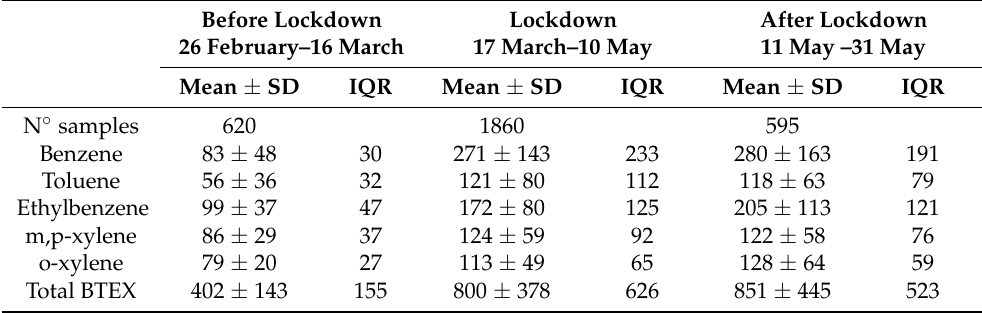
Table 1. Average mixing ratios (pptv) of BTEX for each period (before, during, and after lockdown) in Orl é ans, France (SD: standard deviation, IQR: interquartile range). Before